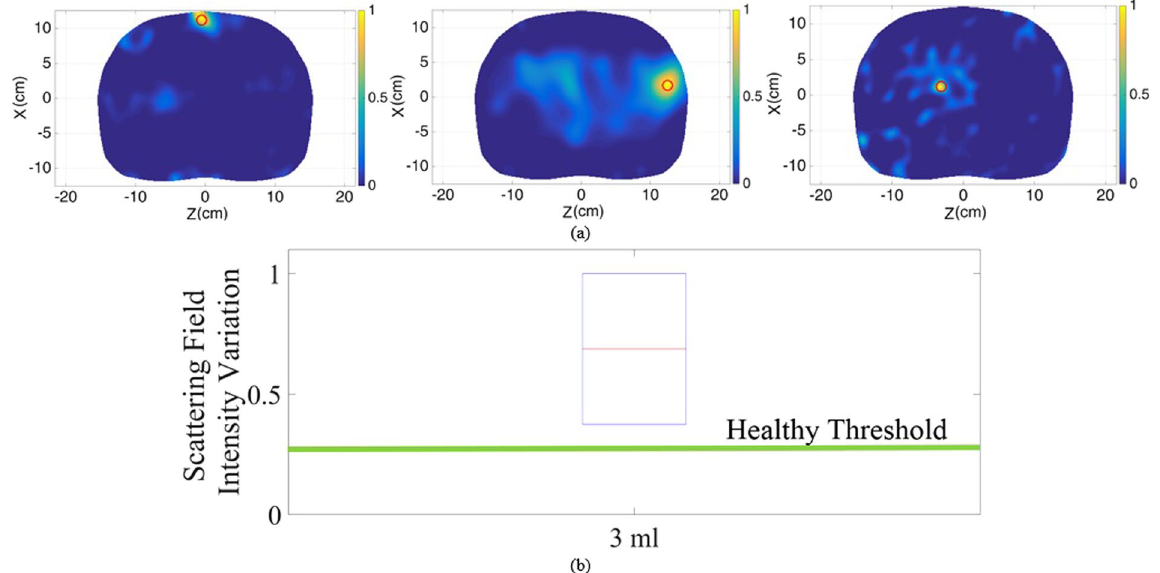
Figure 6. ( a ) Subtracted images of the upper and lower regions at three different positions; front side of the torso left), behind ribs middle) and deep inside thorax right) with 3 mL injected water. ( b ) Scattering field intensity variation diagram in case of 3 mL inserted water compared to the healthy threshold.